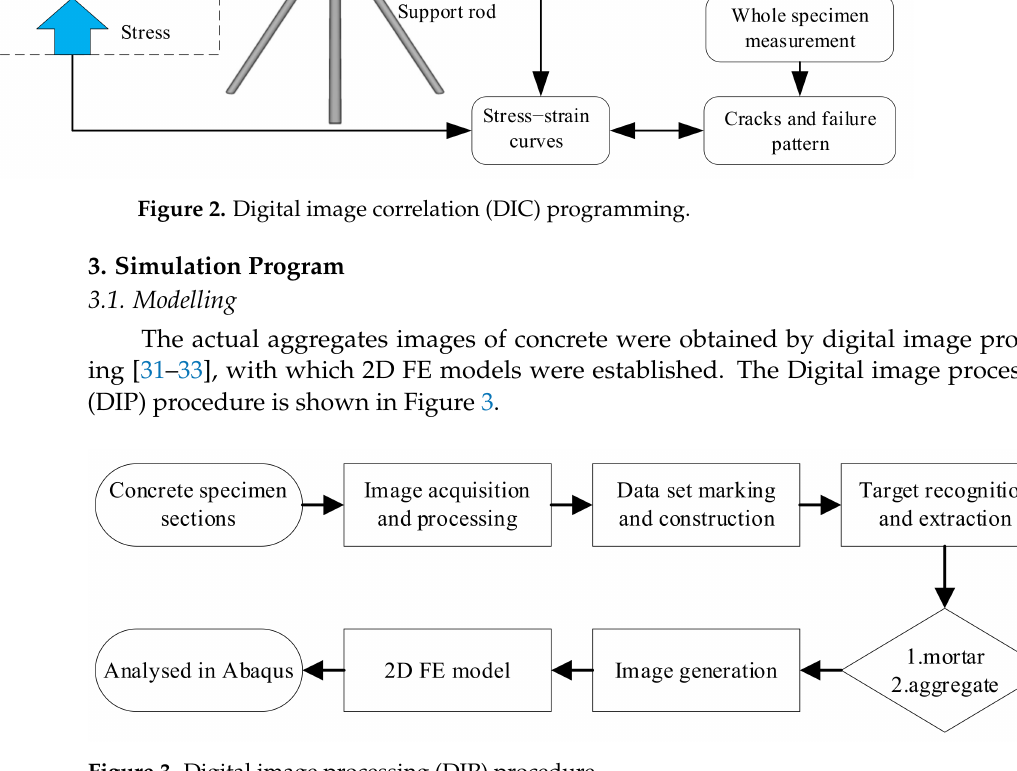
Figure 3. Digital image processing (DIP) procedure.